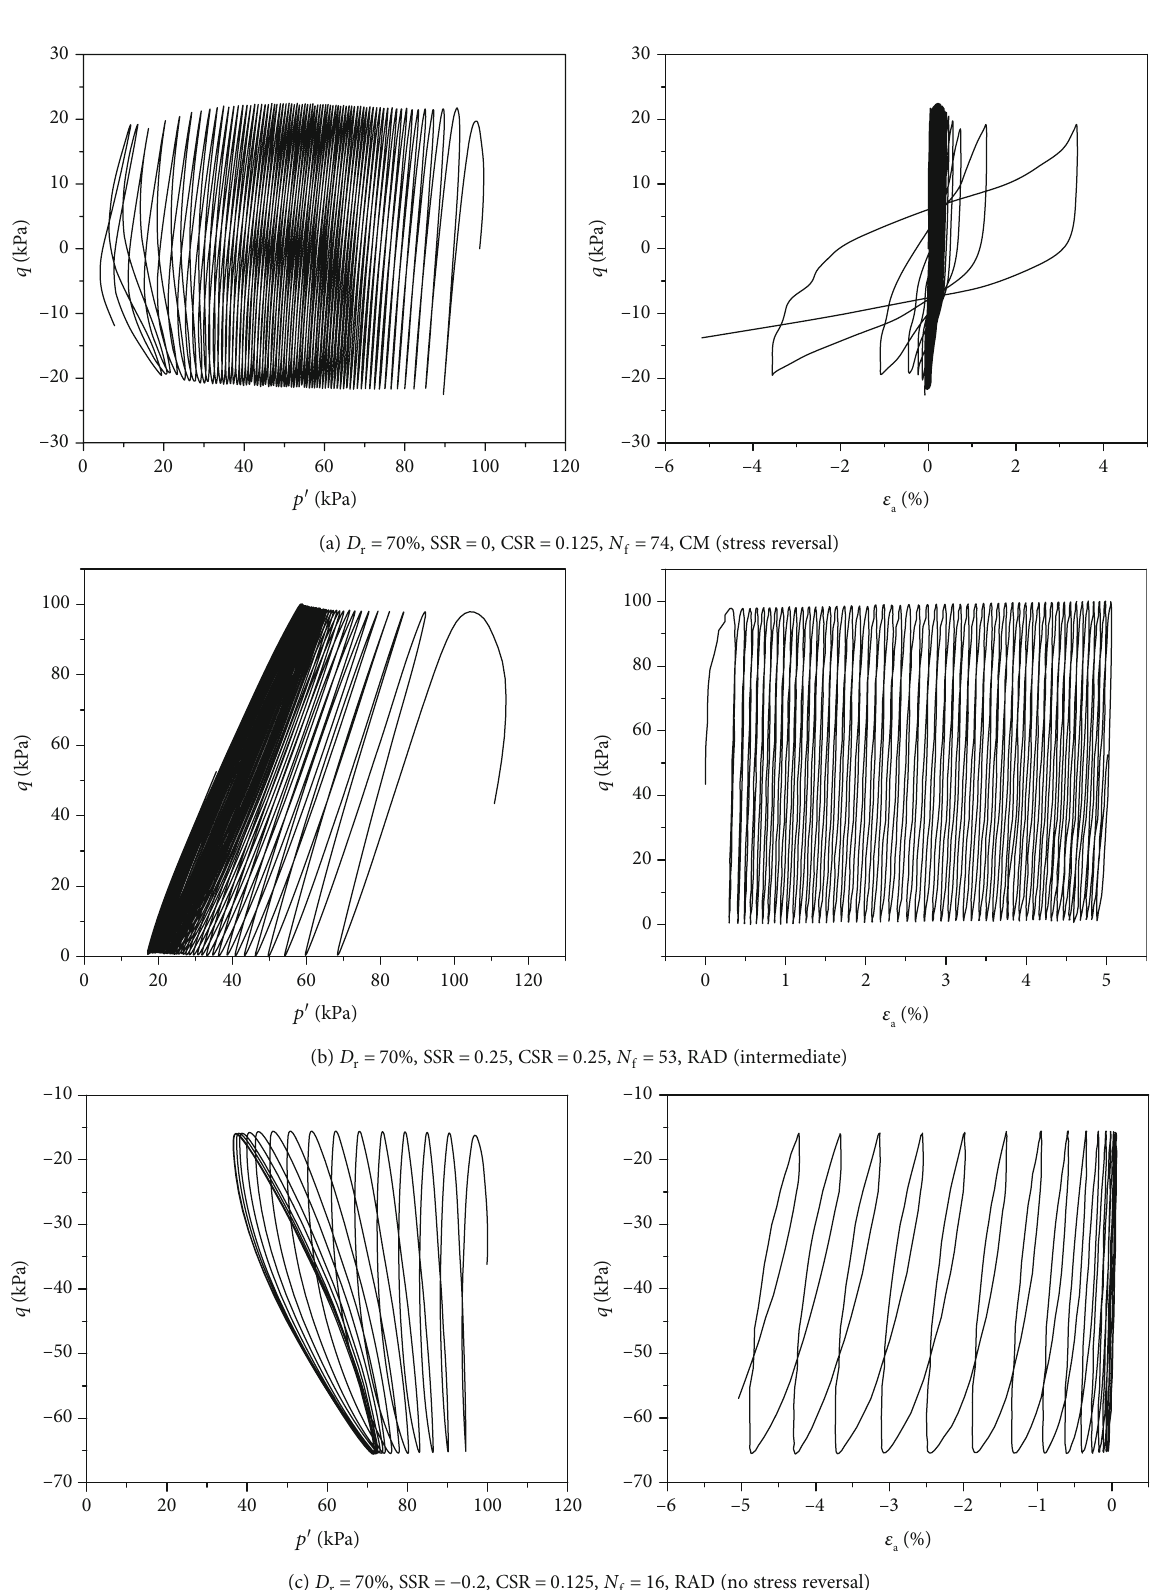
Figure 4: Cyclic response of dense sand with di ff erent initial static deviatoric